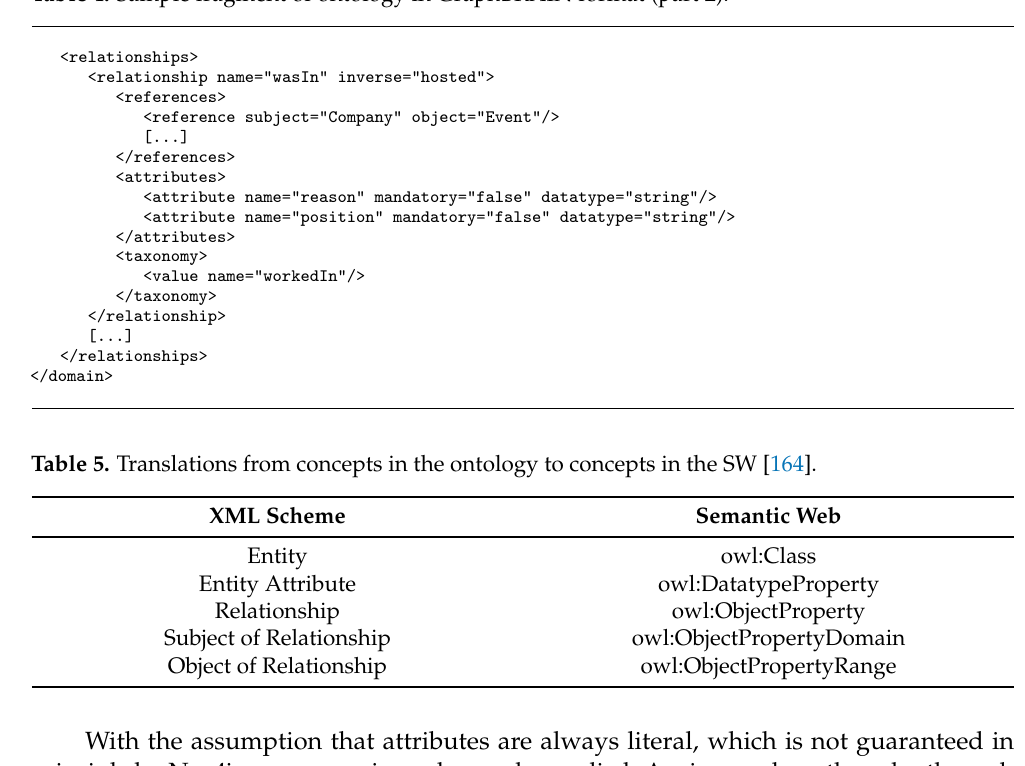
Table 4. Sample fragment of ontology in GraphBRAIN format (part 2).